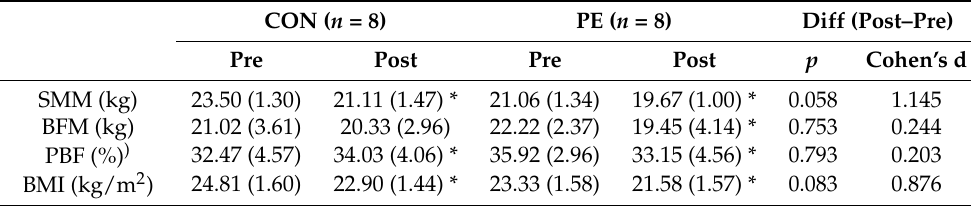
Table 3. Body composition.